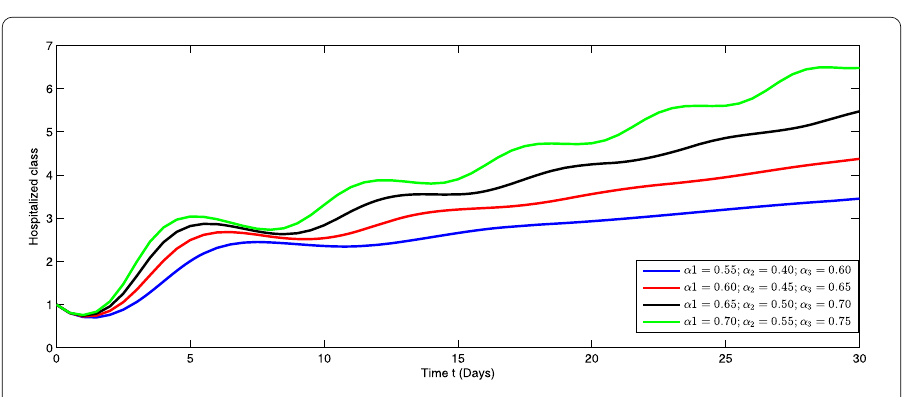
Figure 9 Dynamical behavior of H for different values of α i ( i = 1,2,3) at integer order